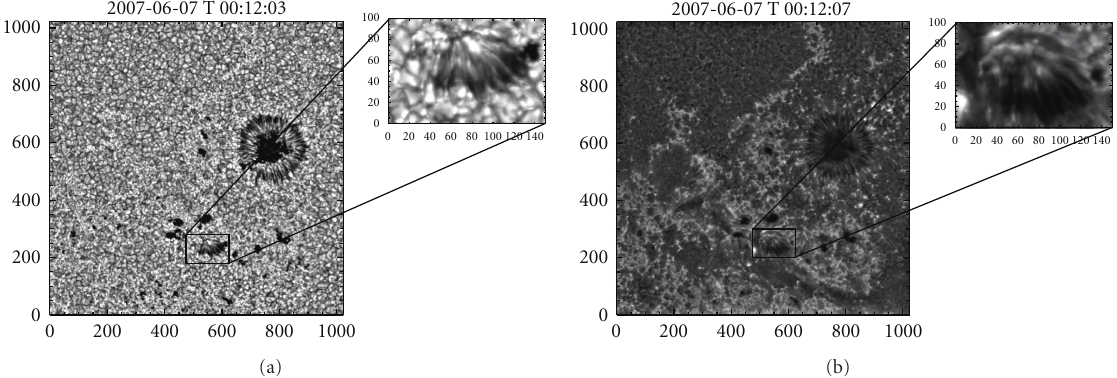
Figure 1: (a) A sample image is obtained from Hinode/SOT using G-band filter. The boxed region shows the region of interest. A magnified view of the region of interest is shown on the right side of it. (b) Same as left side image but obtained in the wavelength of 3968 ˚A of Ca II H. The scales are in unit of pixel.